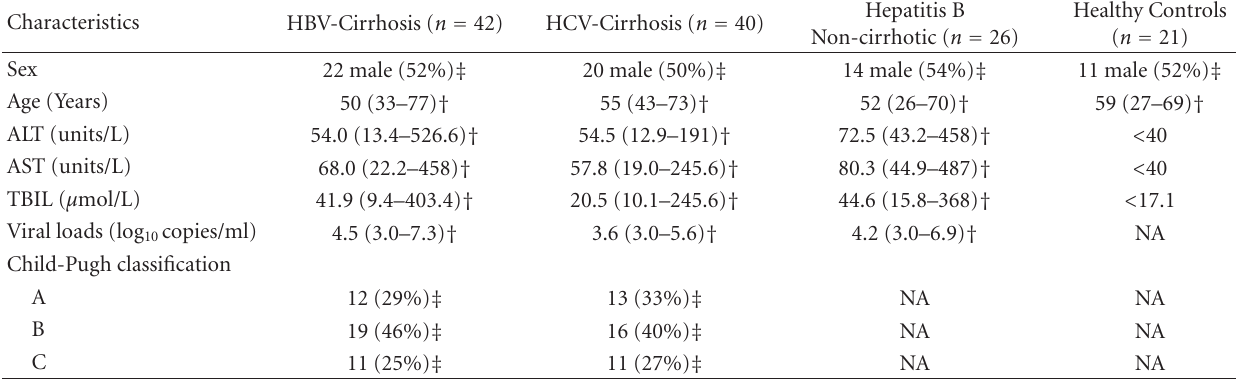
Table 1: Demographic characteristics and clinical